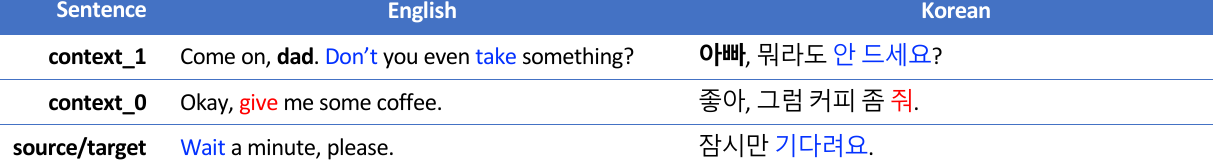
Figure 1. An example of Korean dialogue that is extracted from subtitles. The blue words are verbs that translated into polite form whereas the red words are impolite form, using Korean